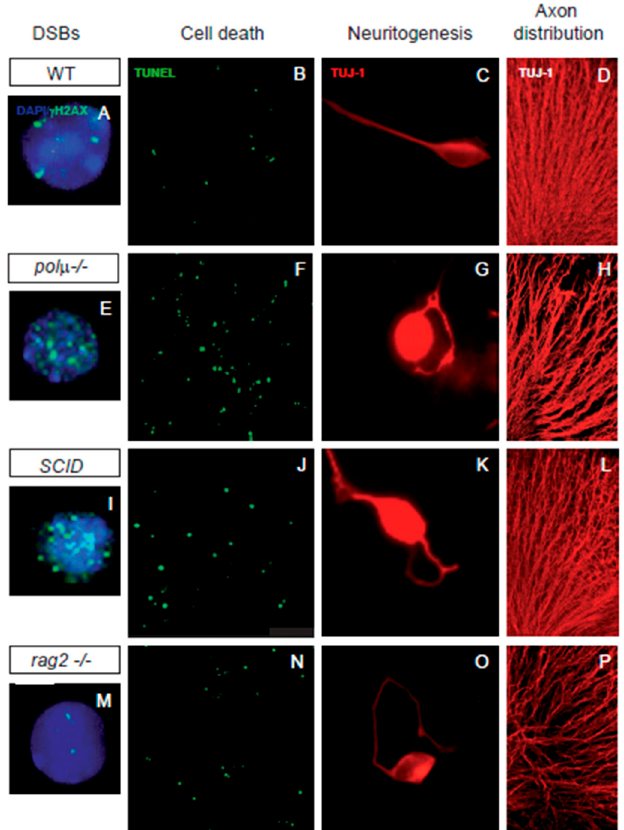
Figure 2. Impaired retinal development in mutant mice defective in components of DSB generation and repair mechanisms. Comparison of retinal phenotypes in mutant mice defective in DNA poly- merase mu (pol µ -/-; E-H), DNA-PK (SCID; I-L), and one of the subunits of the RAG-1,2 endonuclease responsible for generating the DSBs that originate the V(d)J recombination in the immune system (rag2-/-; M-P). The phenotype of the WT mouse is displayed in panels ( A – D,A , E , I , M ) E13.5 dissociated retinal cells were immunostained for γ H2AX (cyan) to reveal DSBs and counterstained with DAPI (blue) to visualize the nuclei. Notice that the foci numbers are increased in the repair defective mutants and reduced in the RAG2 defective mutant, with respect to the WT. ( B , F , J , N ) programmed cell death was detected by TUNEL (green) in whole mount E13.5 retinas. Notice that apoptotic nuclei numbers are increased in all three mutant mice with respect to the WT mouse. ( C , G , K , O ) E13.5 dissociated retinal cells were cultured on polyornithine/laminin-treated plates. Neurite emission was visualized by TUJ-1 immunostaining (red). Notice the disturbed axonal tra- jectories in all three mutant mice, with respect to the WT mouse. ( D , H , L , P ) E13.5 whole-mount ret- inas were immunostained with TUJ-1 (red) to visualize RGC axonal trajectories. Notice the dis- turbed axonal trajectories in all three mutant mice, with respect to the WT mouse. Images adapted from [48,49,62,85].